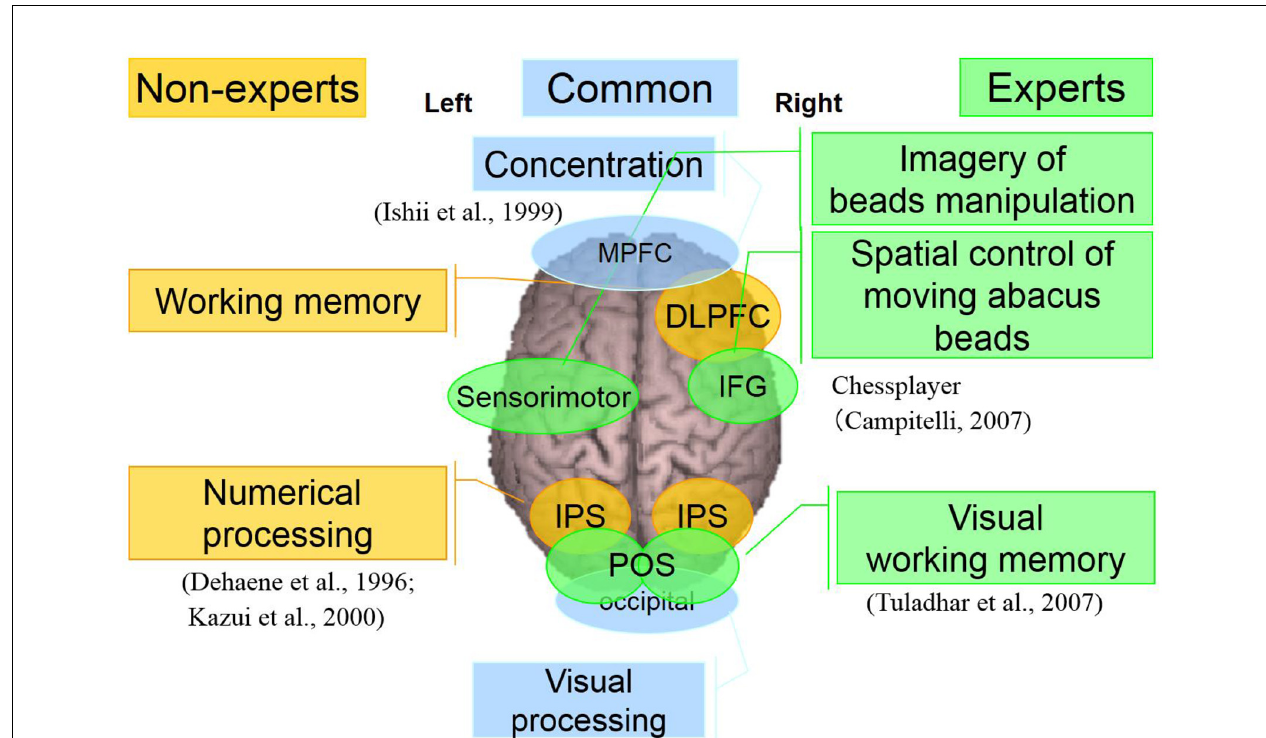
FIGURE 11 | A neural processing mechanism of mental calculation based on cerebral oscillatory changes for Abacus experts and non-experts.